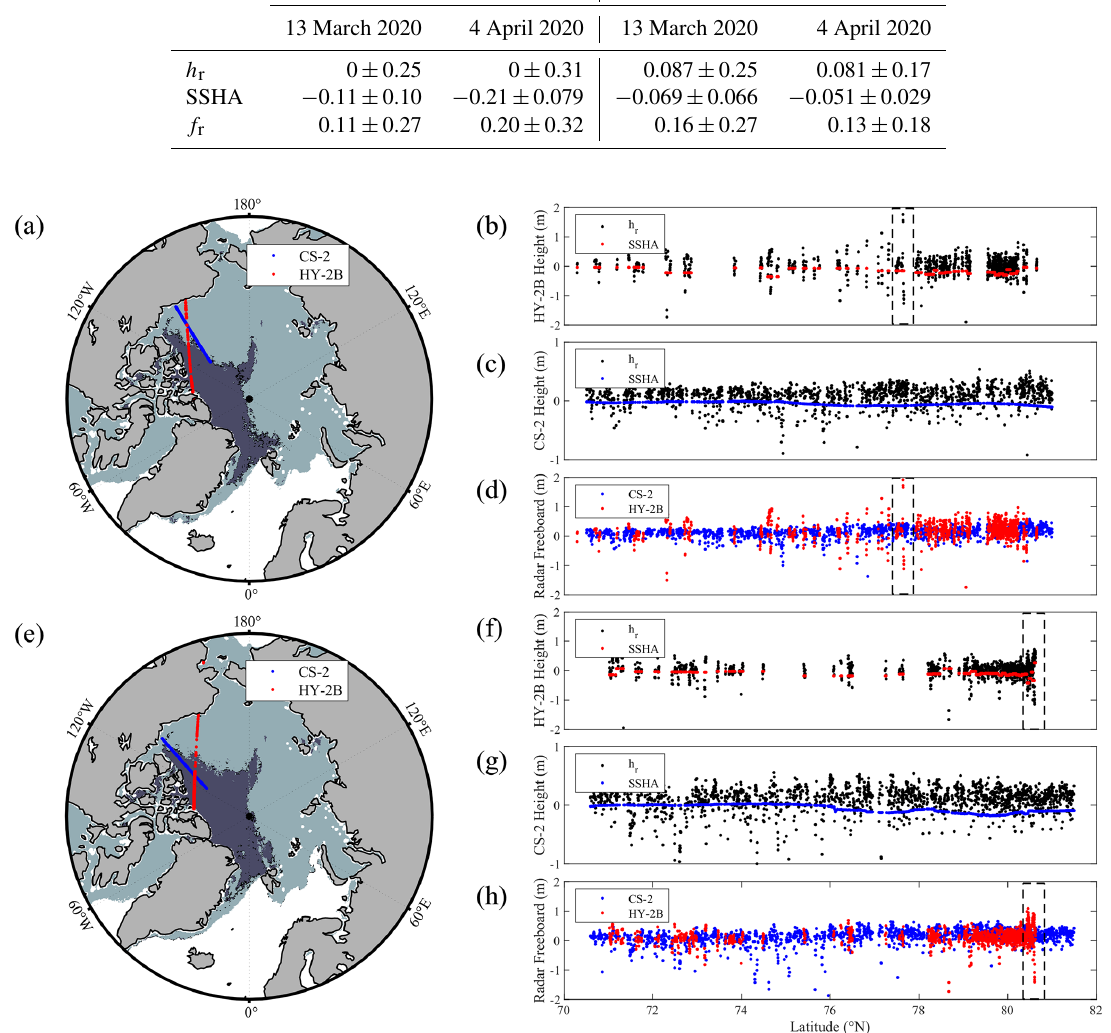
Figure 4. (a, e) CryoSat-2 (blue) and HY-2B (red) tracks (acquired on 4 April and 13 March 2020, respectively) selected for comparison. FYI regions: light shading; MYI regions: dark grey shading. (b, f) HY-2B relative surface elevations of floes (black dots) and SSHAs (red dots) corresponding to the tracks shown in panels (a) and (e) , respectively. (c, g) CryoSat-2 relative surface elevations of floes (black dots) and SSHAs (red dots) corresponding to the tracks shown in panels (a) and (e) , respectively. (d, h) CryoSat-2 (blue) and HY-2B (red) radar freeboard values corresponding to the tracks shown in panels (a) and (e) ,